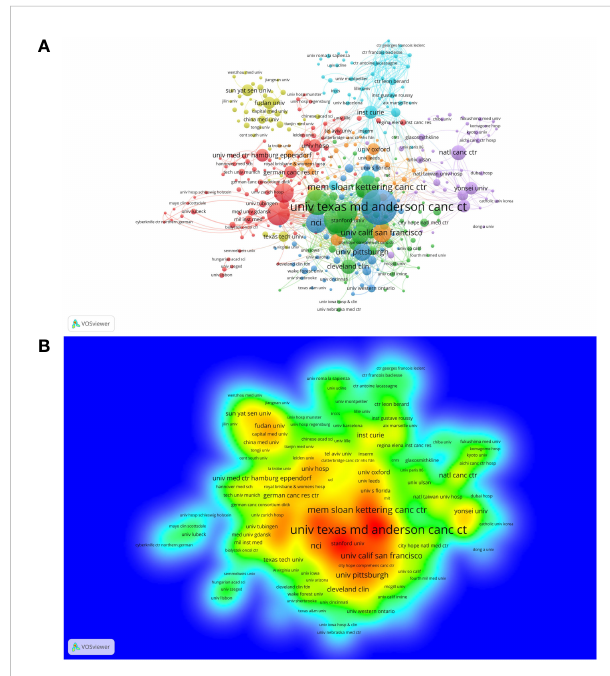
FIGURE 5 The co-occurrence cluster and production density of institutions. (A) cluster network analysis of institutions with at least fi ve publications. The size of the node is proportional to the number of publications of a speci fi c institution. The bigger the node, the more productive the institution. When two institutions occurred in the same publication for three times, there is a link between them. The width of the link represents the strength of co-occurrence between two institutions. Nodes and links in the same color belong to the same cluster, meaning the connections between these institutions are more closer according to the VOSviewer analysis. (B) The density map of institutions based on the number of publications. The labels of institutions in red area are the most productive institutions, while labels in the blue area are the less productive ones. From: